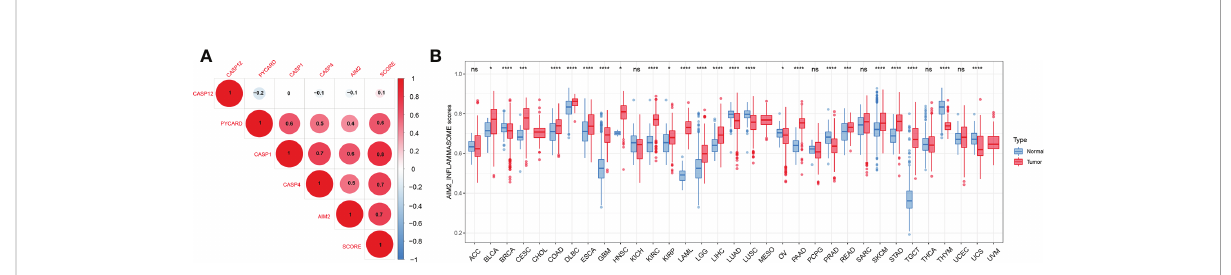
FIGURE 6 Differential expression of the AIM2 in fl ammasomes scores. (A) Correlation analysis of AIM2 in fl ammasome-related genes expression. The shades of color indicate the magnitude of the correlation, with red dots representing positive correlation and blue dots representing negative correlation. The size of the dots represents the correlation coef fi cient, the larger the dot, the stronger the correlation (Spearman ’ s correlation test). (B) AIM2 in fl ammasomes scores between tumor and normal samples for 33 cancers. *p < 0.05, ***p < 0.001, and ****p < 0.0001 ; ns, no statistical signi fi cance. (Student ’ s